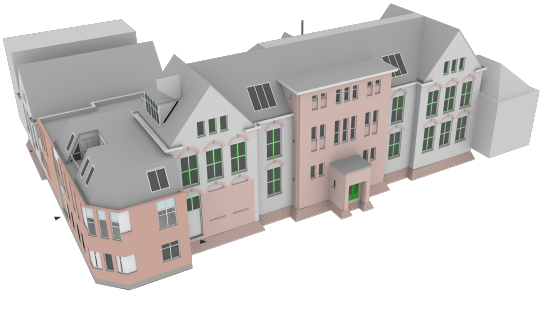
Figure 5. Witte de